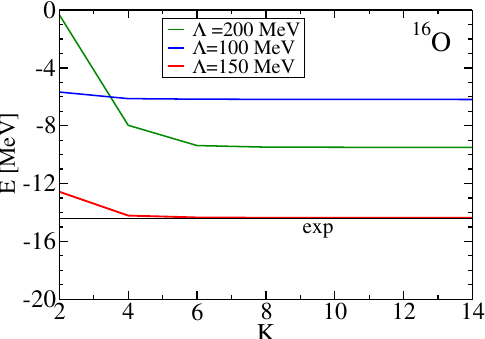
Figure 3: Convergence of 9 Be ground state en- ergy as a function of the HH quantum number = 130 MeV. K with Λ αα = Λ α n